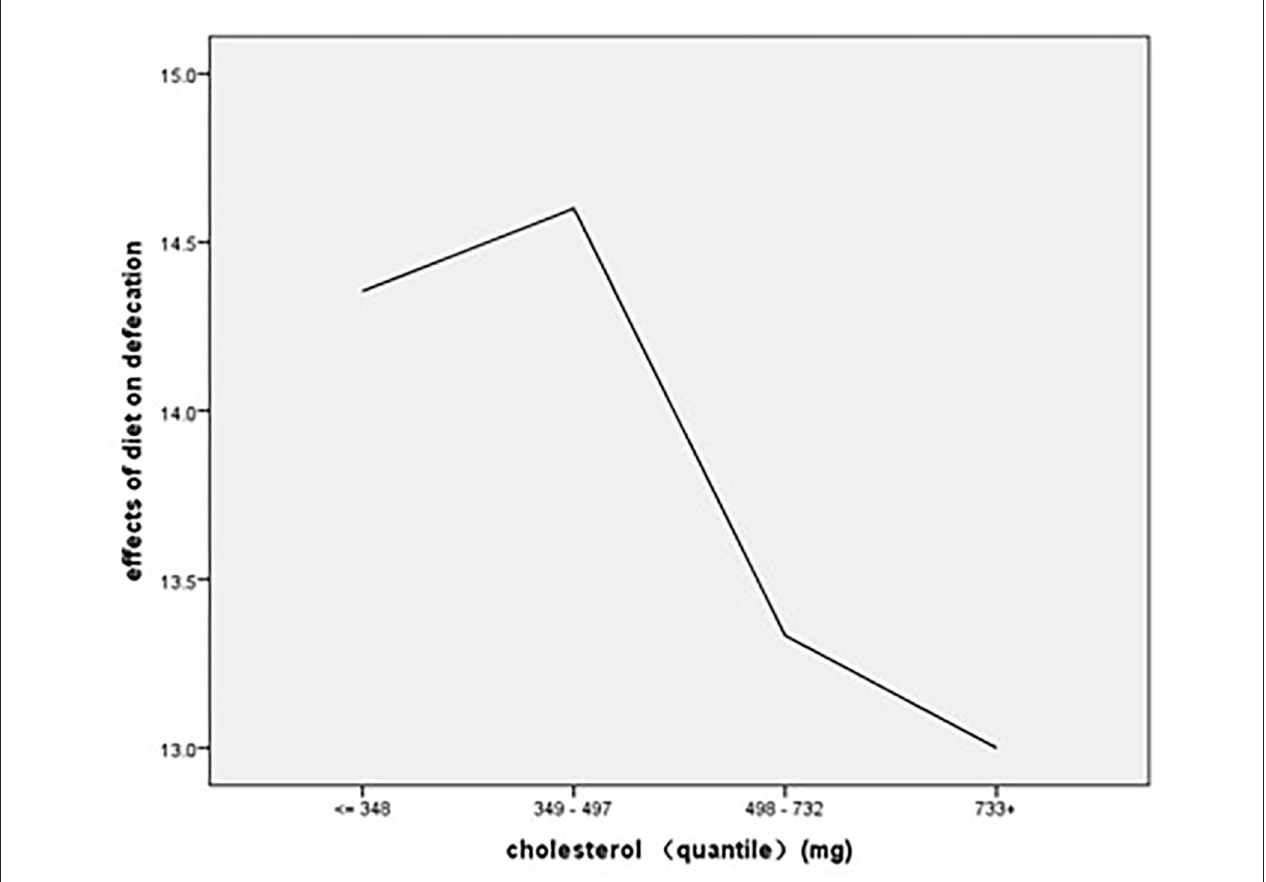
FIGURE 5 | The association of stratified quintiles of consumption of cholesterol with effects of diet on defecation.